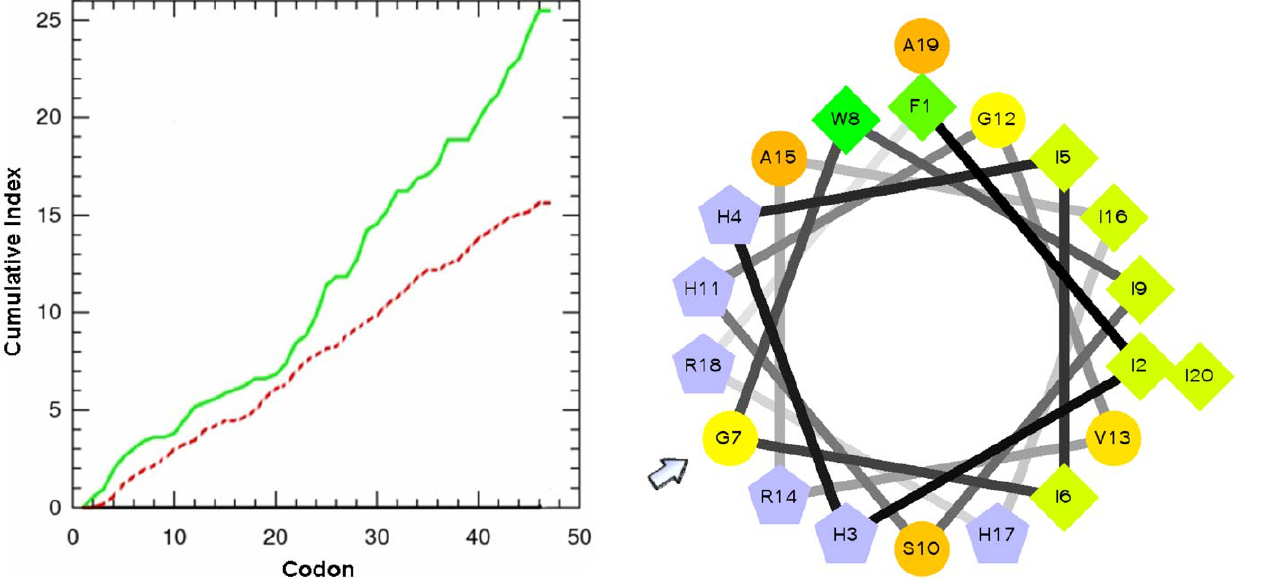
Figure 3. Average synonymous versus nonsynonymous nucle- otide substitutions in piscidins. Cumulative nonsynonymous (solid green line) and synonymous (dashed red line) substitutions for all pairwise comparisons are plotted along the first 46 residues of the piscidin precursor. Generally the number of nonsynonymous substitu- tions exceeds the synonymous replacements throughout the coding sequence. Divergence at nonsynonymous sites is higher in the mature peptide region. dN and dS values for the signal and mature peptides are also indicated above the corresponding regions. doi:10.1371/journal.pone.0009501.g003 PLoS ONE |